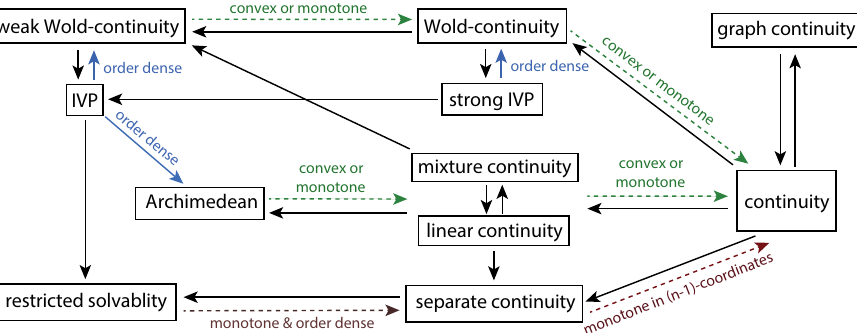
Figure 2. A pictorial representation of Proposition 9, and Theorems 15 and 16 connecting continuity postulates for a binary